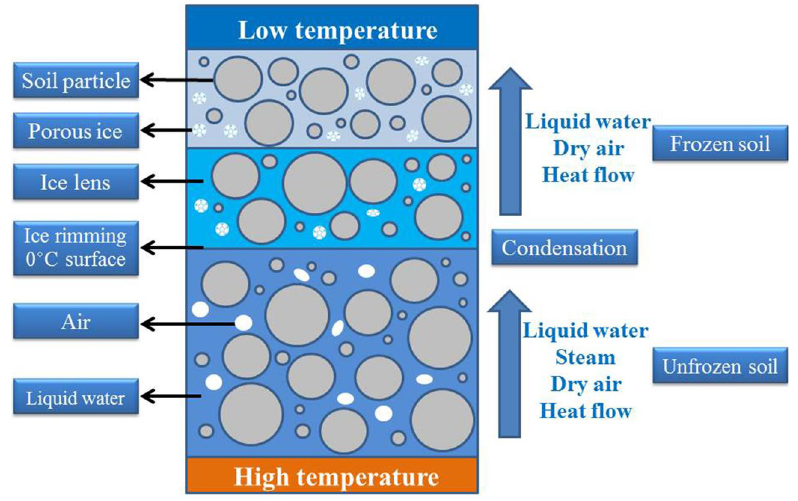
Figure 24. Schematic diagram of capillary frost heaving model of earthen